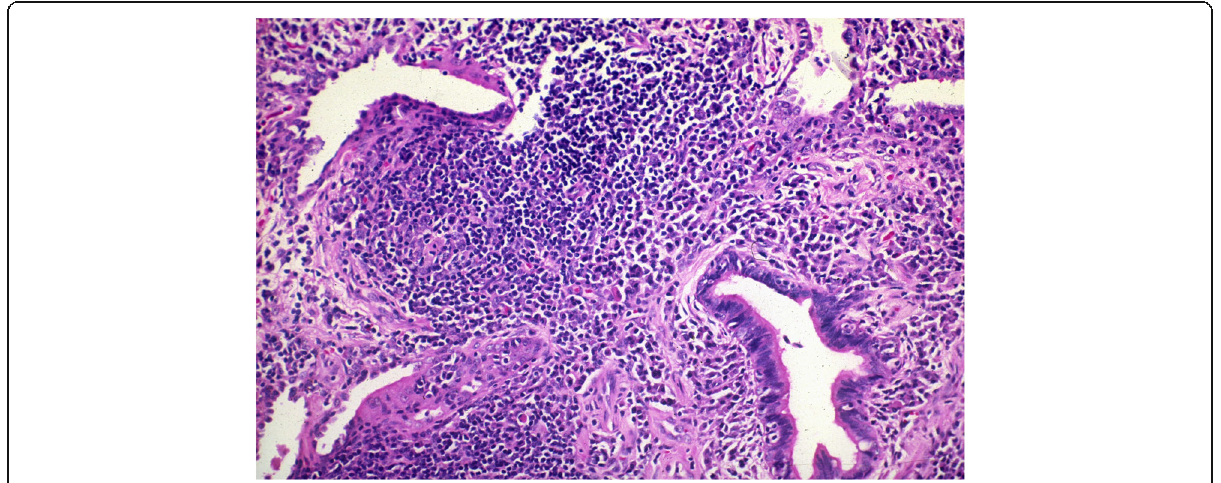
Fig. 12 Hyperplasia of the bronchus-associated lymphoid tissue (BALT hyperplasia), another sign of autoimmune diseases. H&E,